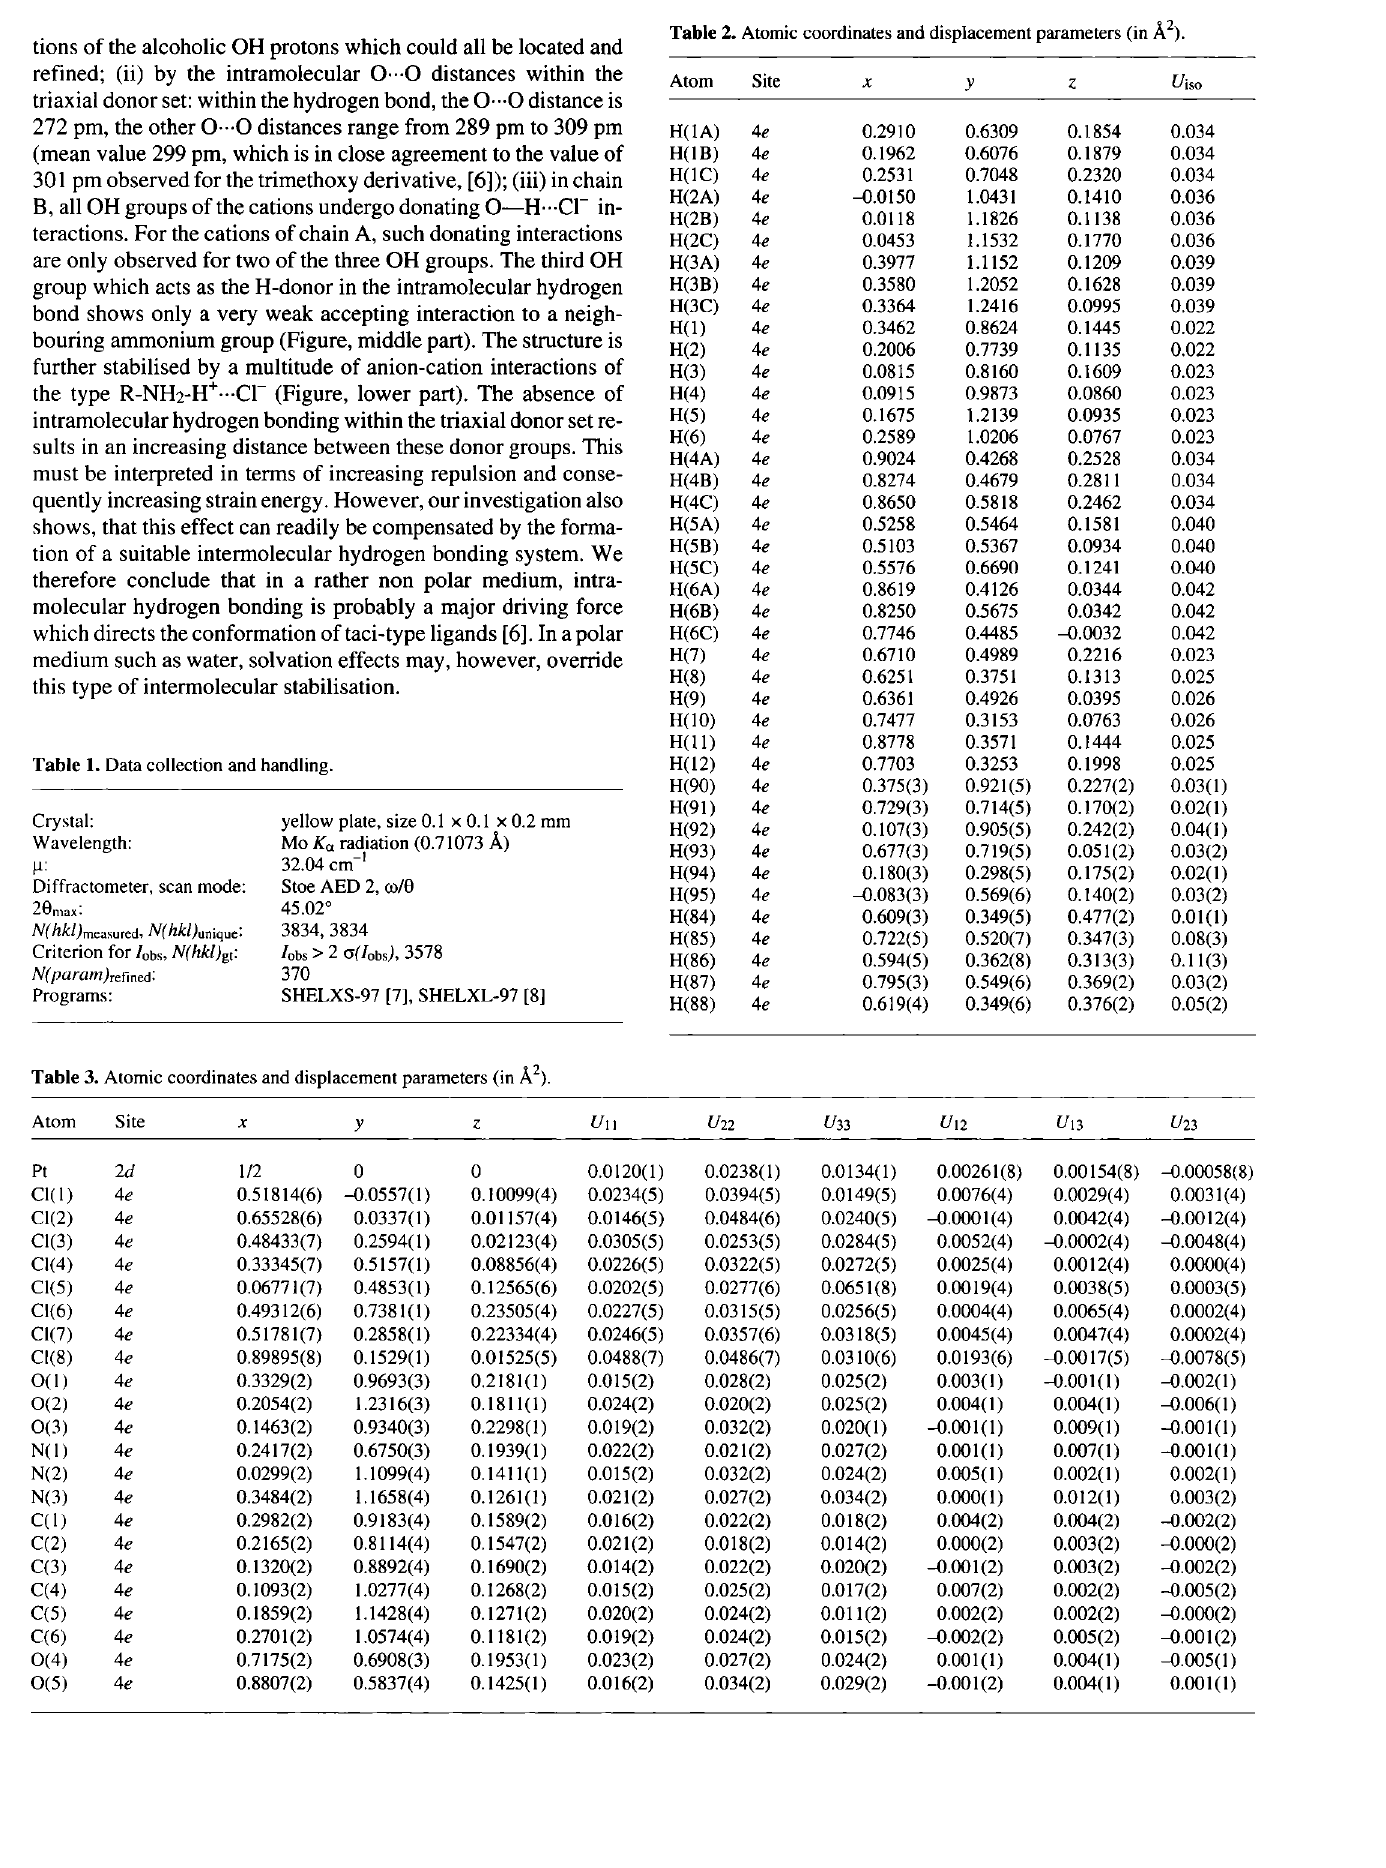
Table 2. Atomic coordinates and displacement parameters (in Ä 2 ).